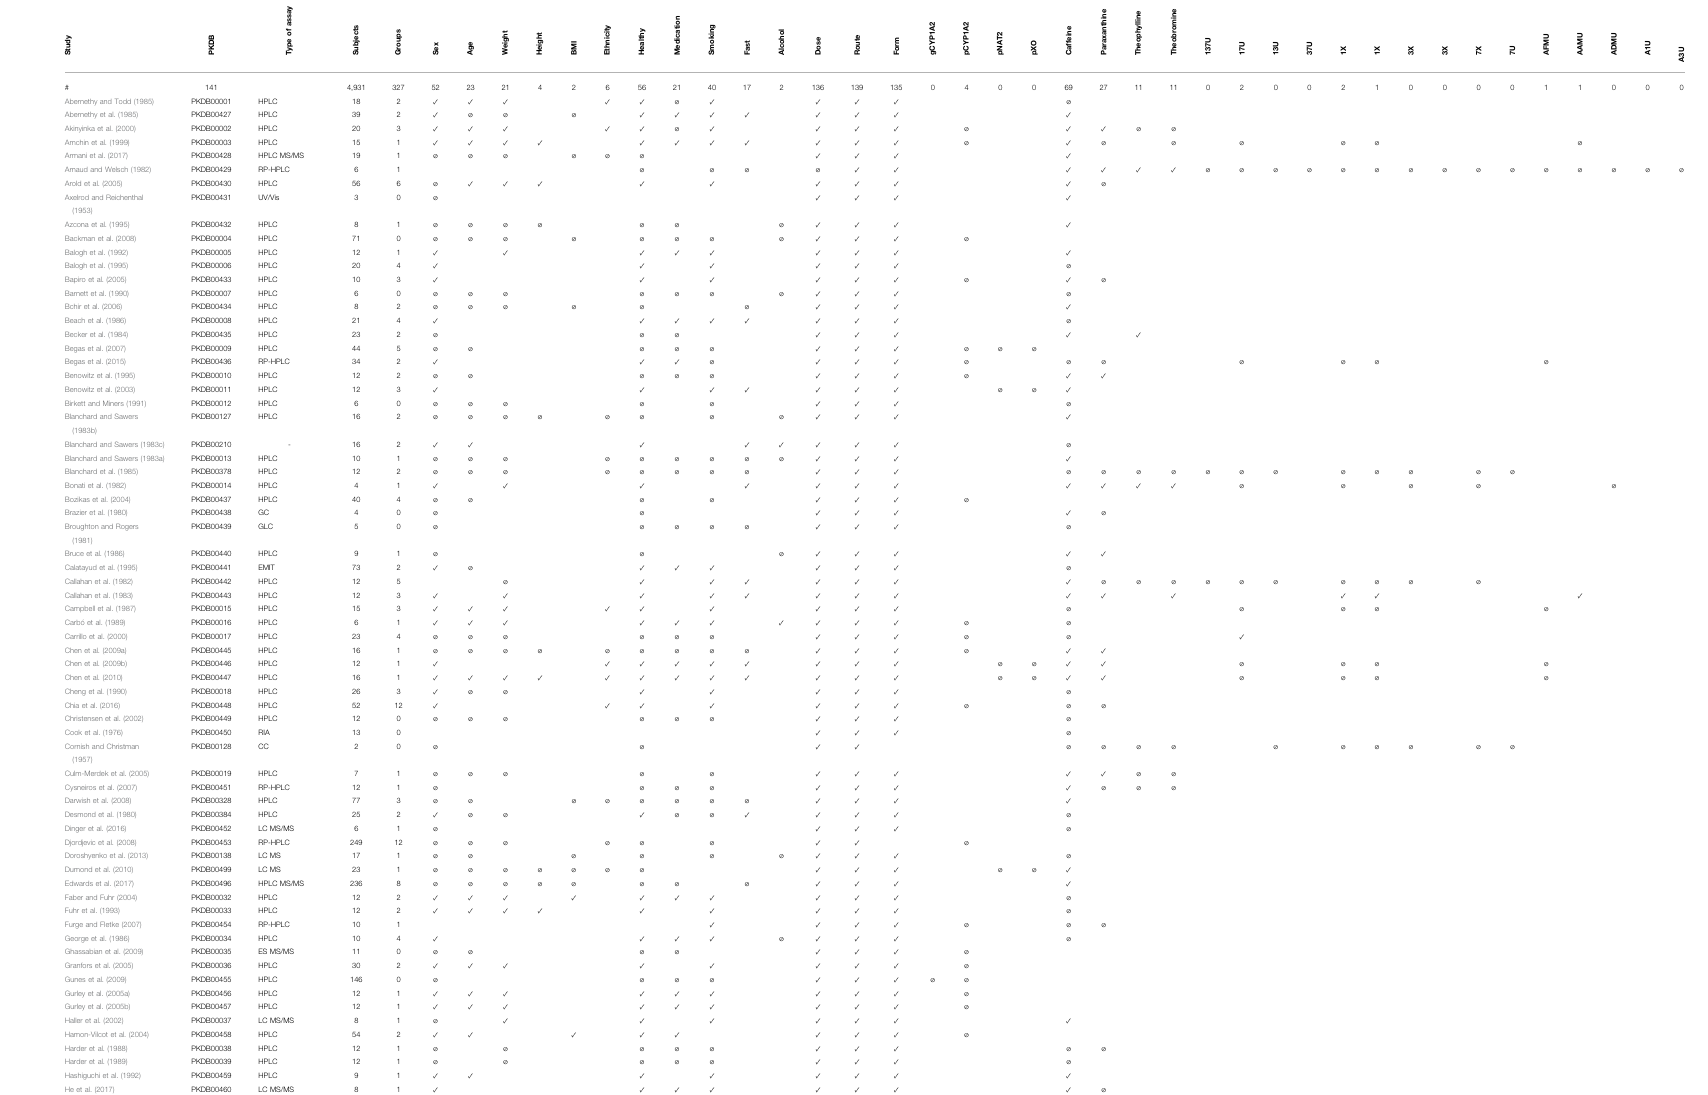
TABLE1| Overviewofcuratedstudies.Foreachstudythetableshowswhichinformationwasreported.Either,informationwasreported( ✓ ),partiallyreported( ⊘ )ornotreportedatall(whitespace).Thetypeofassaycolumn contains reportedinformation onquanti fi cationmethod fortheconcentration ofcaffeineoritsmetabolites (i.e.,CC:Columnchromatography, GC:Gaschromatography, CGC:Capillary gaschromatography, GLC:Gas- liquid chromatography, GC MS: Gas chromatography mass spectrometry, HPLC: High performance liquid chromatography, HPLC MS/MS: High performance liquid chromatography-tandem mass spectrometry, RP- HPLC: Reversed-phase high-performance liquid chromatography, LC MS Liquid chromatography mass spectrometry, LC MS/MS Liquid chromatography-tandem mass spectrometry, HPLC-ESI-MS/MS: High- performanceliquidchromatography-electrosprayionisationtandemmassspectrometry,ESMS/MS:Electrosprayionisationtandemmassspectrometry,UV/Vis:UV – visiblespectrophotometry,EMIT:Enzymemultiplied immunoassay technique, ELISA: enzyme-linked immunosorbent assay, RIA: